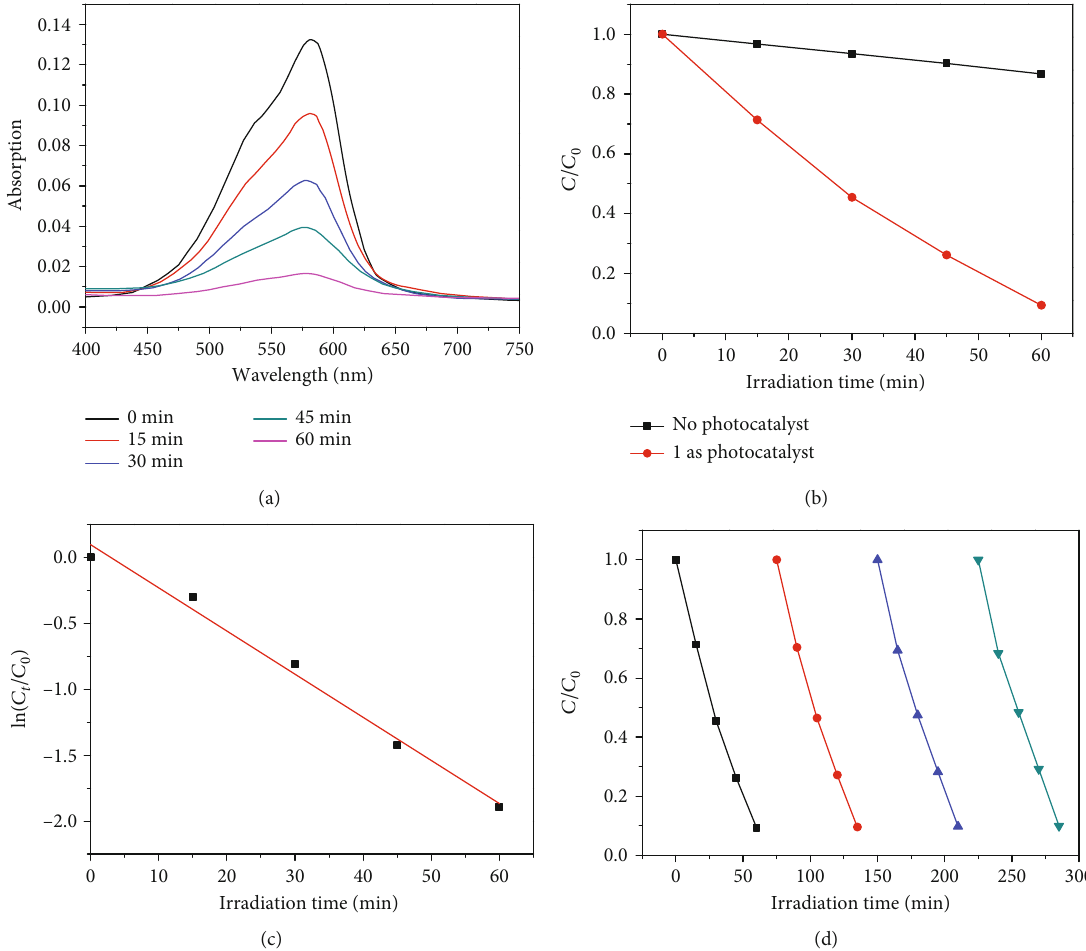
Figure 3: (a) The UV-Vis absorption spectra of MV in the presence of 1 with the increase of irradiation time. (b) Percentage of MV remaining in the solution monitored with time. (c) Photocatalytic degradation kinetic of 1 for MV using fi rst-order kinetic equation of Þ = − κ t + b . (d) Cycling runs for the photocatalytic degradation of MV under UV light irradiation. ln ð C t / C 0